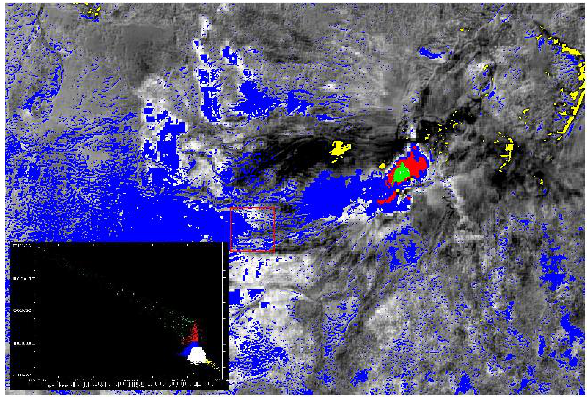
Figure 3. Scatter plot between Ar+Fe between the differences for 2013 and 2018 taking 2017 as a reference (in green 3-sigma, red 2-sigma, blue 1-sigma, yellow 3+sigma).